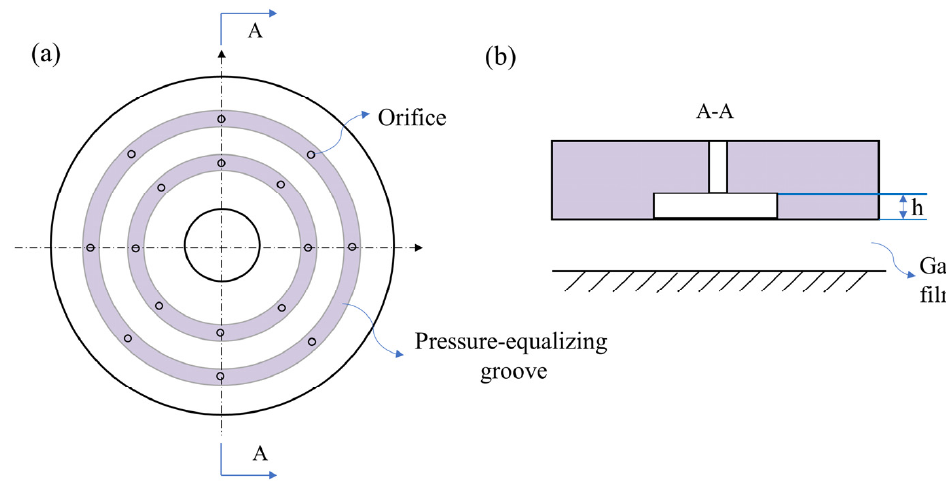
Figure 10. The pressure ‐ equalizing groove. ( a ) front view, ( b ) section view